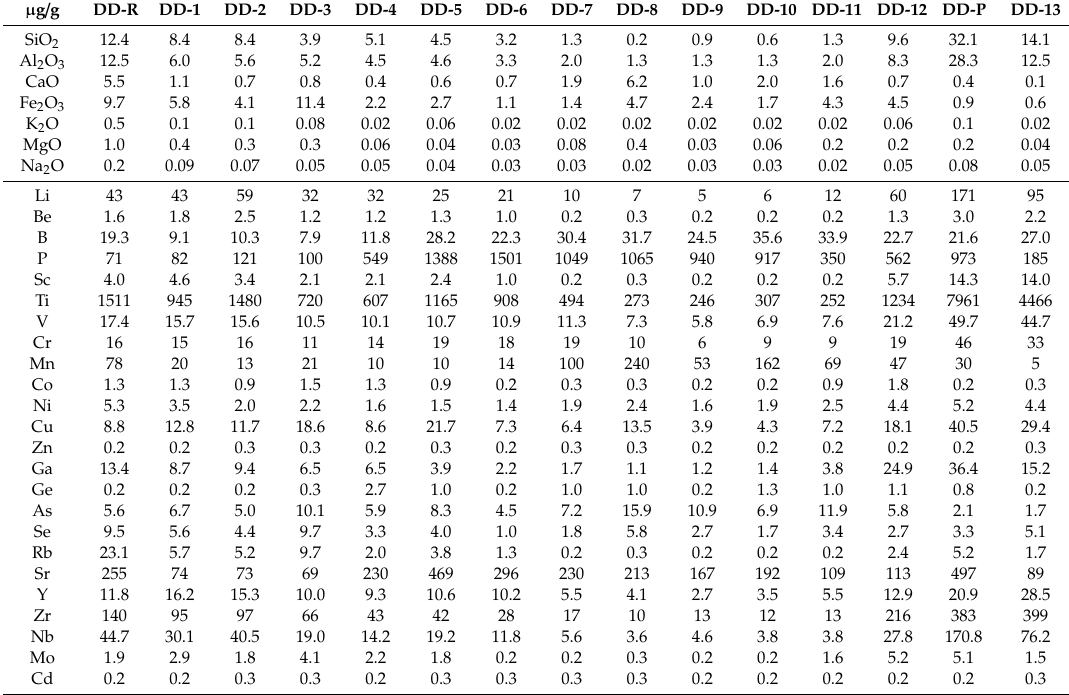
Table A3. Concentrations of major element oxides (%) and trace elements ( µ g / g) of the No.5 coal seam from Dongdong coalmine (on whole-coal